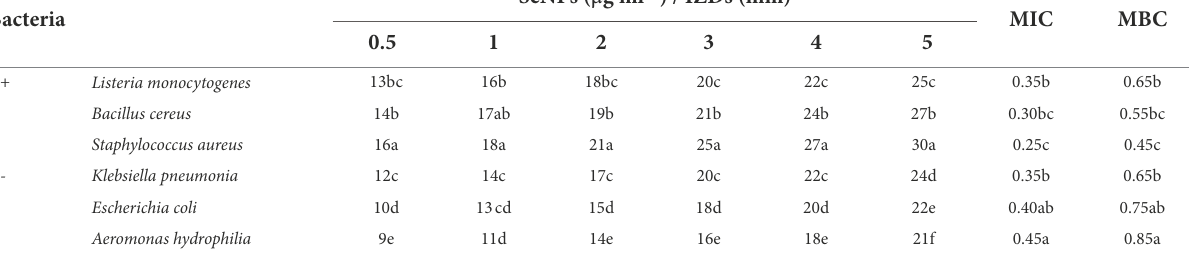
TABLE 1 The inhibition zones diameters (IZDs) of the biosynthesized selenium nanoparticles (BioSeNPs) with minimum inhibitory concentration (MIC) and minimum bactericidal concentration (MBC) levels against certain Gram positive (G+) and Gram negative (G-) pathogenic bacteria.